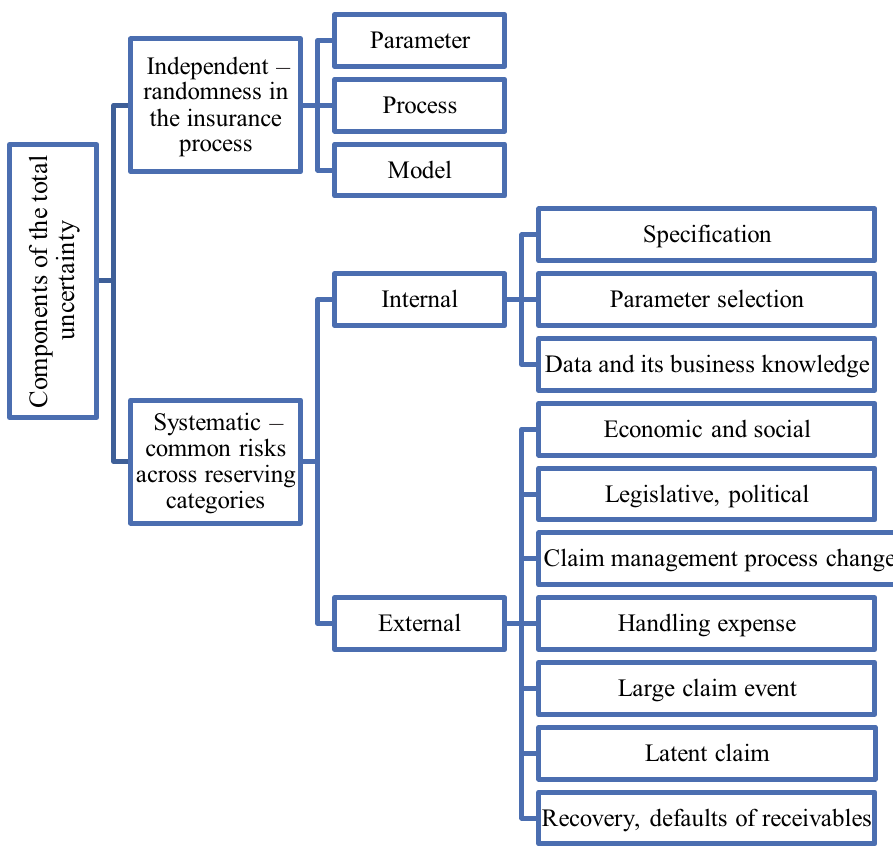
Fig. 1. Types of uncertainty for reserve setting and its capital requirements (created by the authors based on Marshall et al. 2008 and Hindley